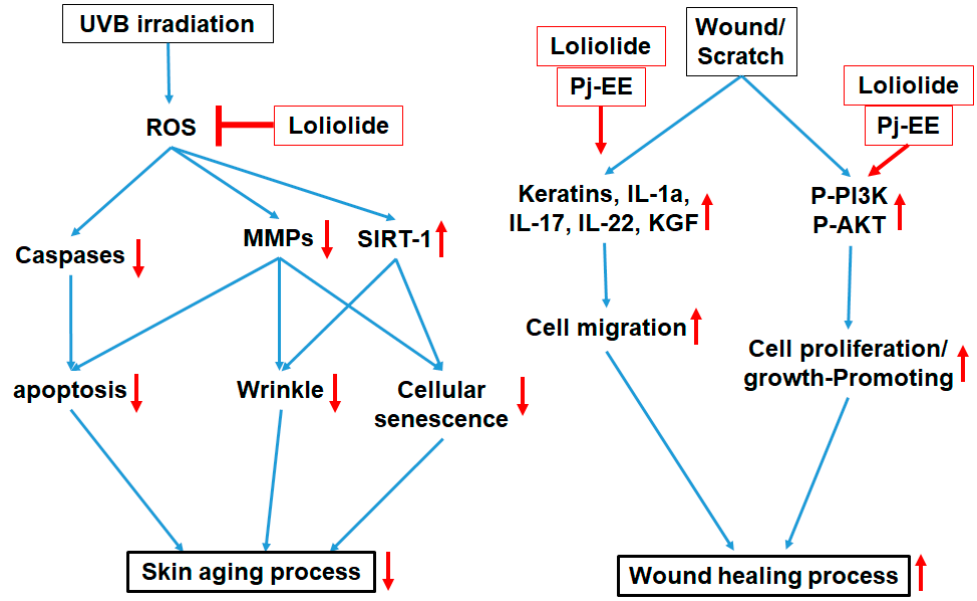
Figure 6. Antiapoptotic, antioxidant, and wound-healing effects of loliolide and Pj–EE in HaCaT